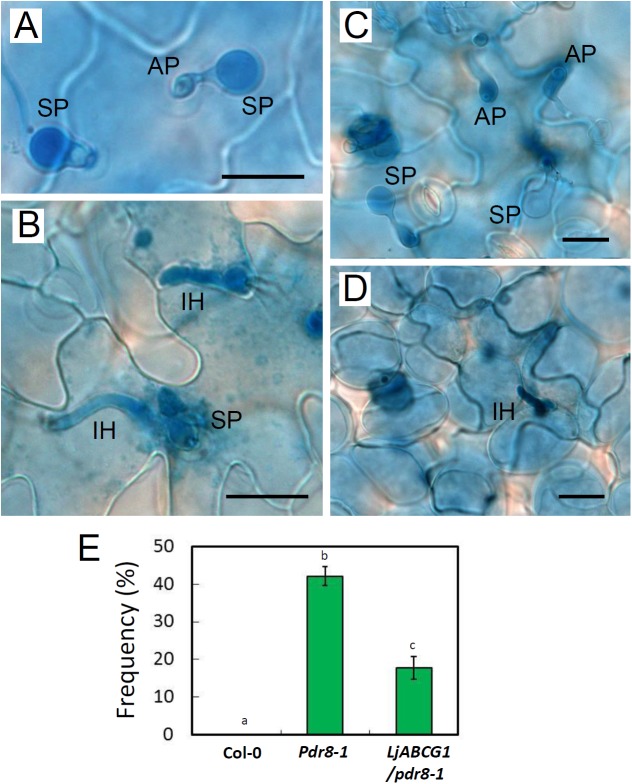
Arabidopsis plants inoculated with P. infestans.Leaves stained with trypan blue were observed under a microscope 24 h after inoculation with P. infestans; (A) Col-0, (B) pdr8-1, (C) LjABCG1/pdr8-1. (D) Beneath image of C. (A-D) SP, spore; AP, appressorium; IH, infection hyphae. Bars = 20 μm. (E) Frequency of penetration of P. infestans into leaf epidermal cells. Different letters indicate significant differences (p<0.05) in one-way ANOVA with Tukey's HSD test.